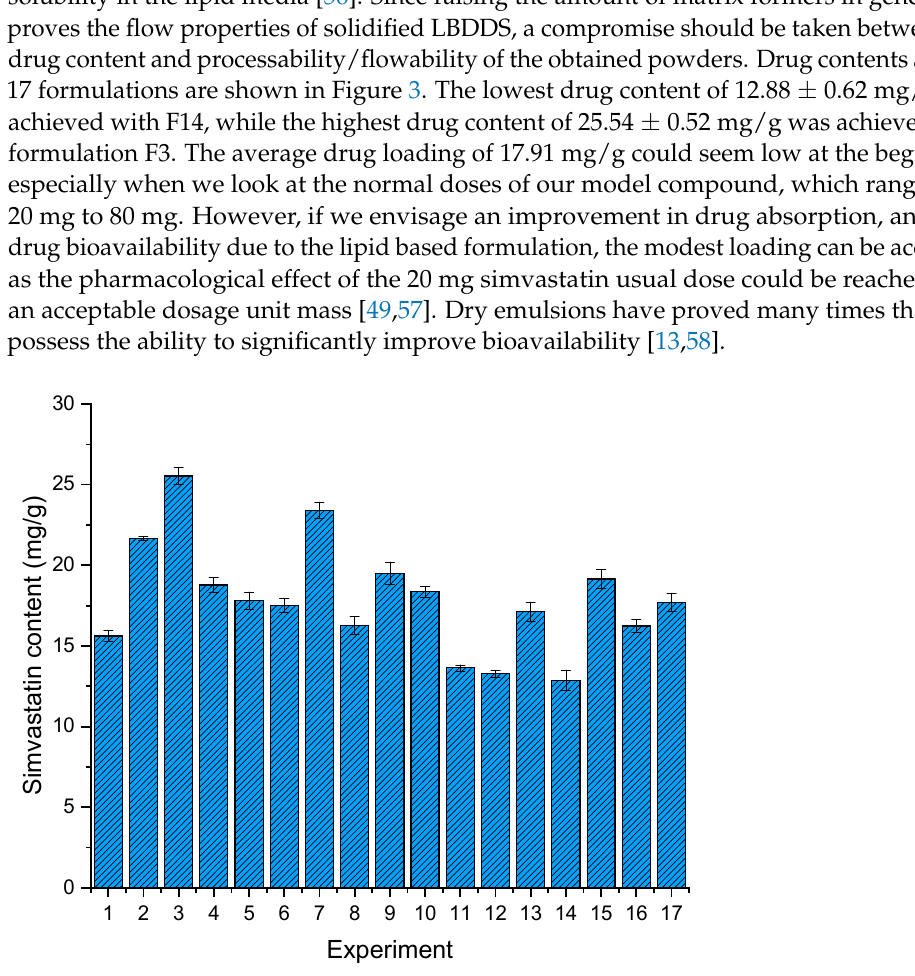
Figure 3. Drug content across 17 experiments, determined by UPLC analysis.